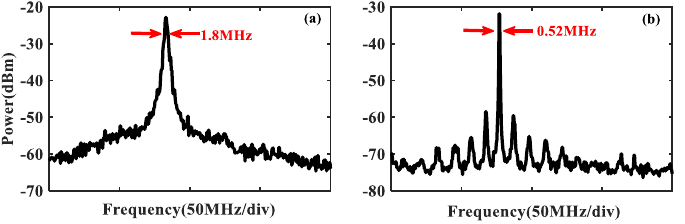
Figure 6. Power spectra of the DM laser ( a ) without and ( b ) with optical feedback. The injection parameters ( Δ f , ξ inj ) = (15 GHz, 0.92).